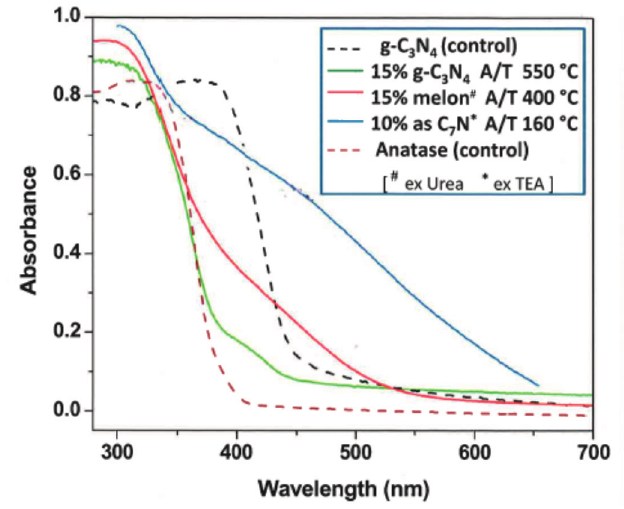
Figure 10. Melon and related tri- s -triazine unit (ringed) as building block for g-C 3 N 4 (adapted from [143] with permission of Wiley).